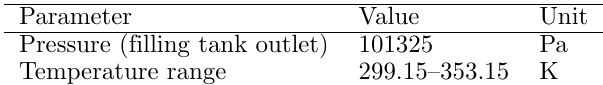
Table 2. Main operational data for DYNASTY (water as working fluid).